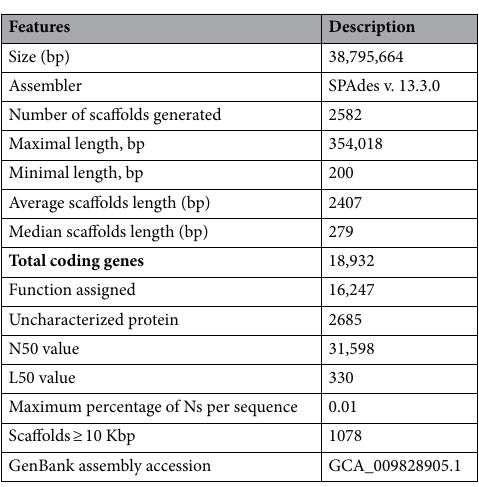
Table 4. Genomic features of the isolated A. sydowii